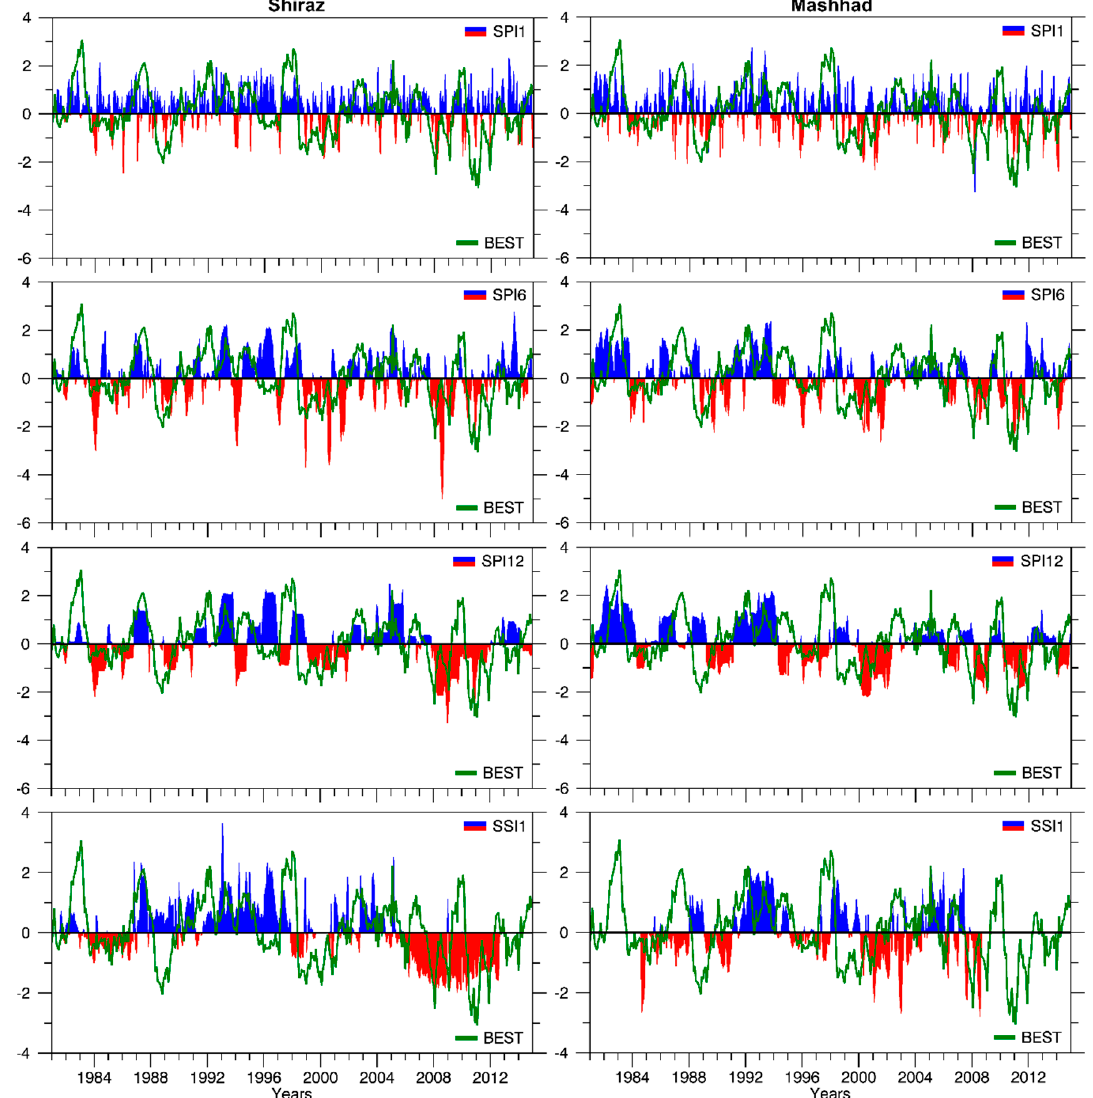
Figure 6. Temporal variations of 1-month, 6-month, and 12-month SPI and SSI with the variations of BEST in the Shiraz and Mashhad boxes. Negative SPI and SSI values—drought conditions in red, positive SPI and SSI values—wet conditions in blue and BEST variations in green color.